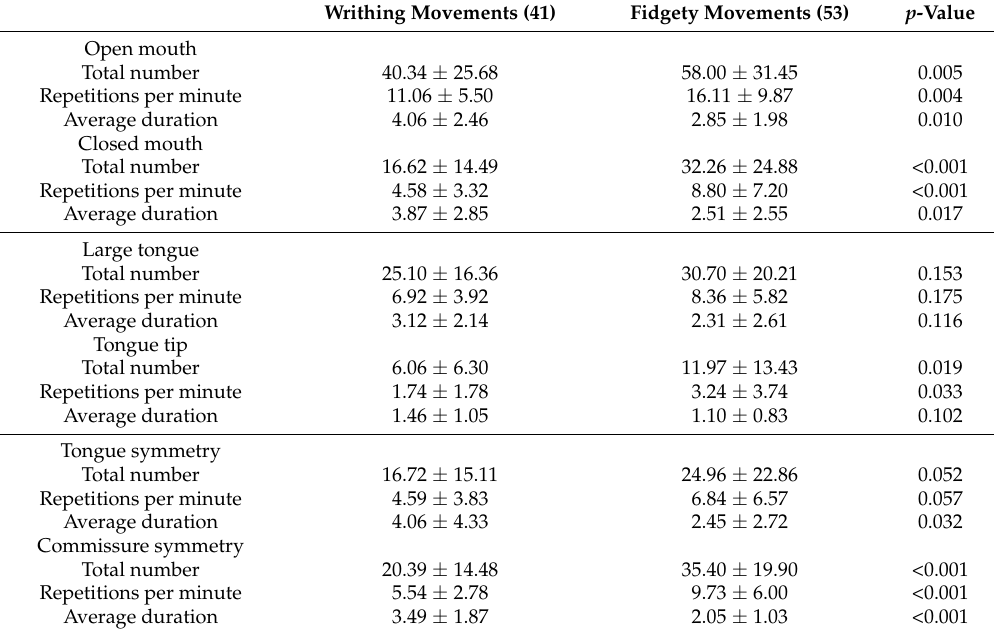
Table 4. Records of oral movements (means and standard deviations) for infants in the writhing and fidgety movements stages of Prechtl’s general movements